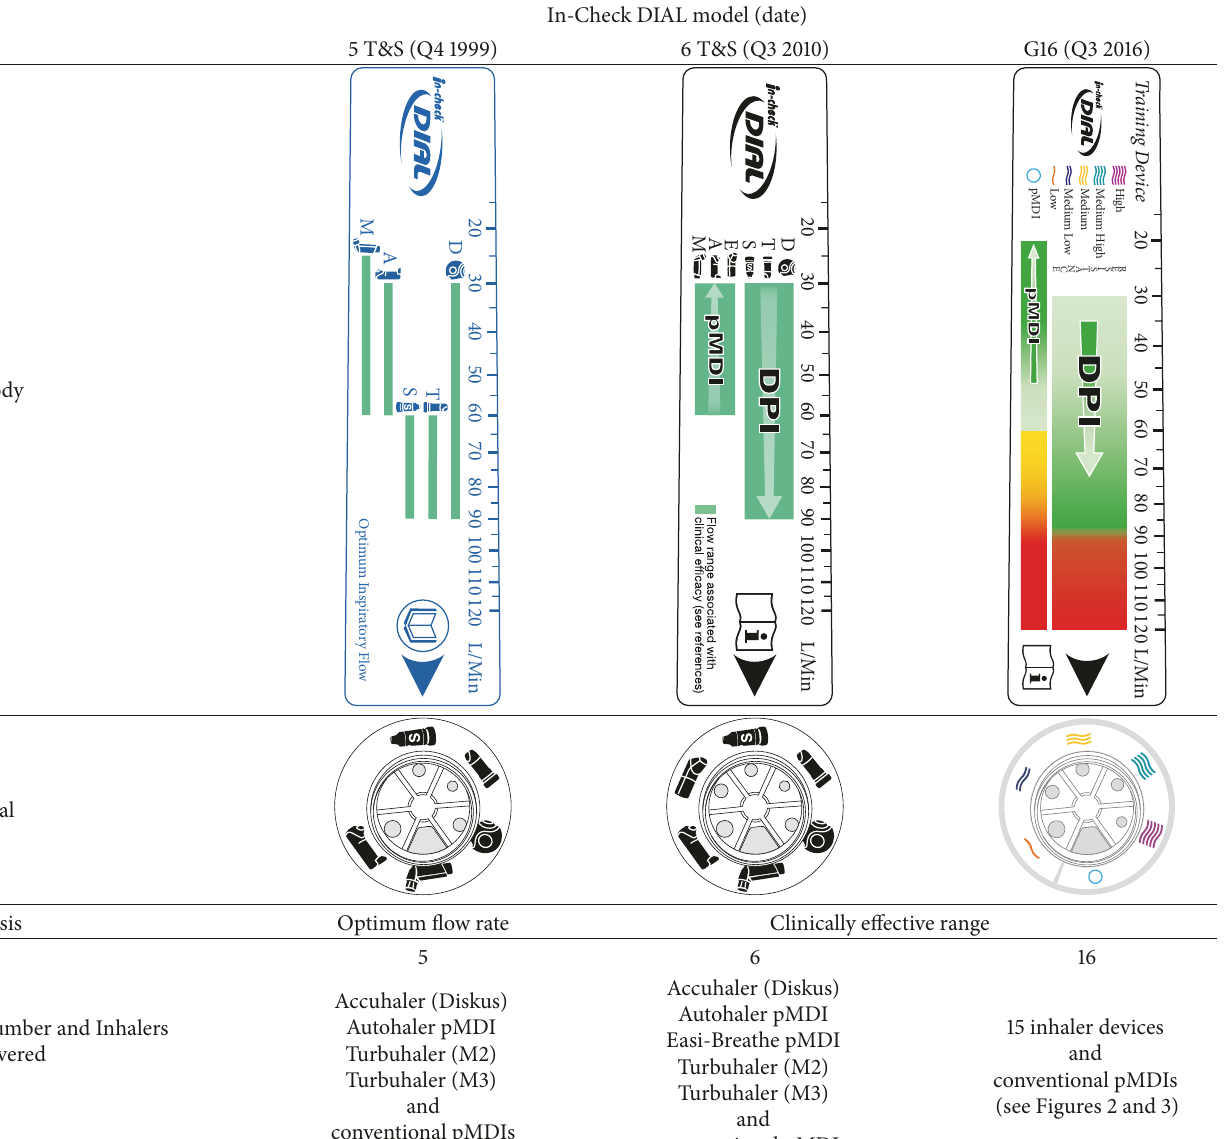
Table 1: Timeframe and scope of In-Check DIAL